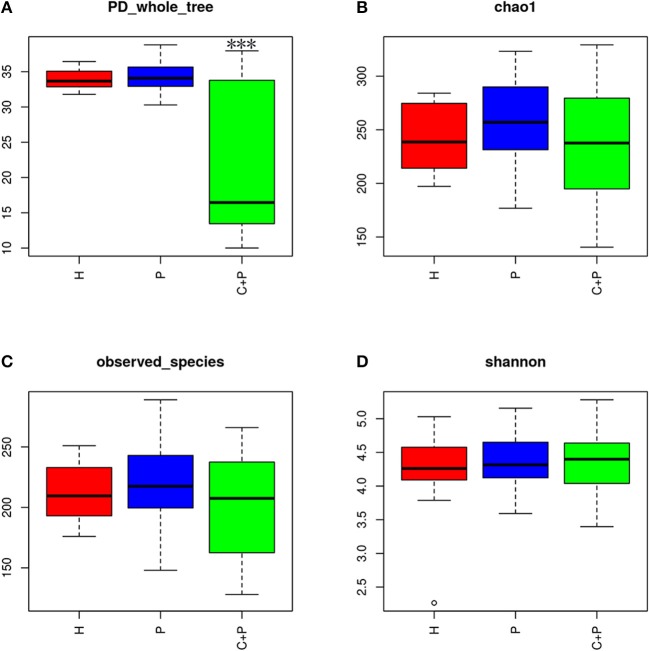
Alpha diversity of the saliva microbiome in patients with periodontitis (P), patients with periodontitis, and COPD (C+P), and healthy controls (H). (A) The phylogenetic diversity (PD) whole tree is a kind of diversity index calculated based on a phylogenetic tree. The *** shows significant differences (P < 0.05) tested using ANOVA in the PD whole tree index. (B) Chao1 is an abundance index and (D) Shannon is a diversity index. (C) Observed species is the index of all amount of OTUs detected.